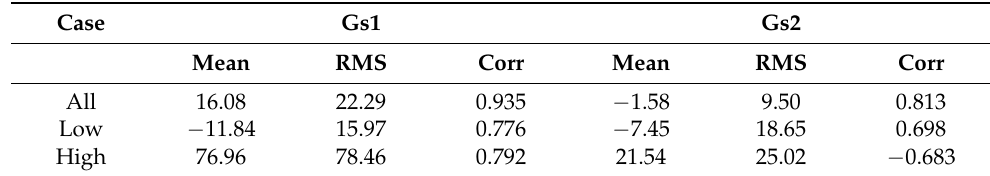
Table 8. Statistical results for the differences between three different sample groups and SeaPRISM us- ing AERONET aerosol data source and two sun glint correction strategies. Mean and RMS are 10,000 x reflectance. Corr is correlation coefficient between difference (bias) and diffuse fraction (1 − f s ). Case Gs1 Gs2 Mean RMS Corr Mean RMS Corr All 16.08 22.29 0.935 − 1.58 9.50 0.813 Low − 11.84 15.97 0.776 − 7.45 18.65 0.698 High 76.96 78.46 0.792 21.54 25.02 −